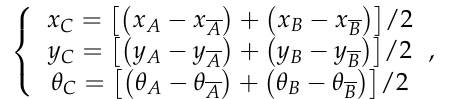
Figure 2. Schematic diagram of the anchor sealing platform.